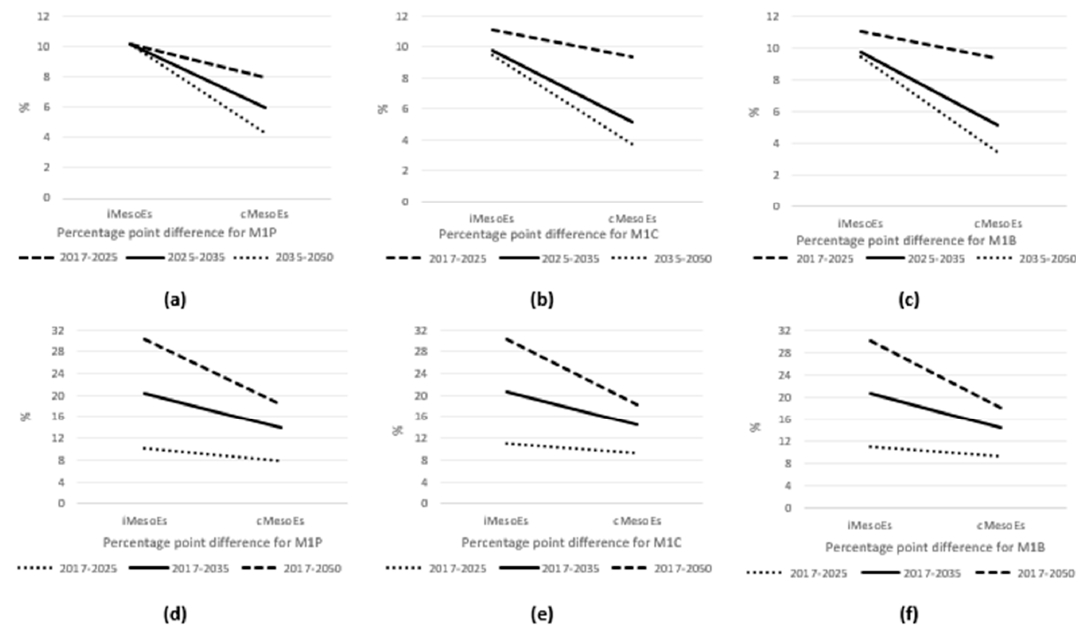
Figure 7. Percentage point differences between M1 scenarios. ( a ) percentage point difference for M1P; ( b ) percentage point difference for M1C; ( c ) percentage point difference for M1B; ( d ) percentage point difference for M1P with respect to 2017; ( e ) percentage point difference for M1C with respect to 2017; ( f ) percentage point difference for M1B with respect to 2017.